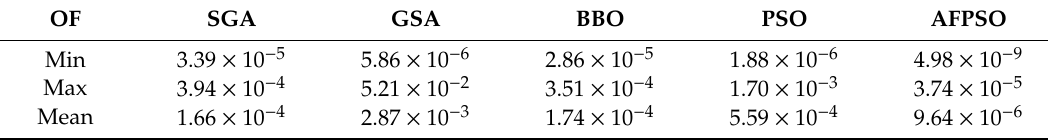
Table 5. Statistical results of optimal fitness obtained by different algorithms in 30 tests (no-load